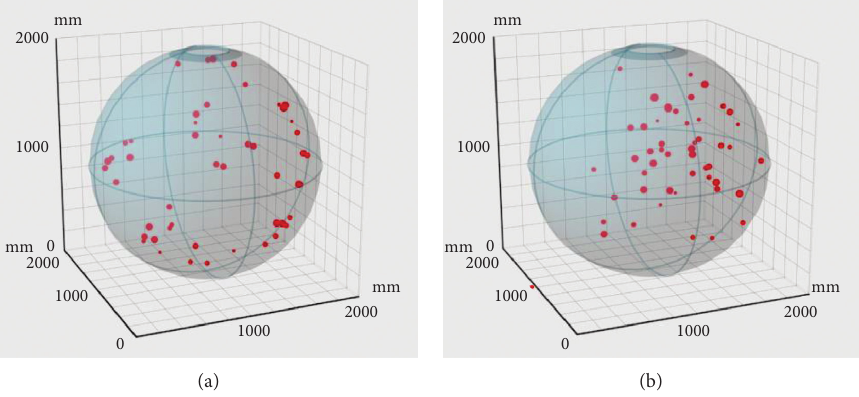
Figure 11: Results of multiobjective genetic algorithm for manned submersible cabin layout. (a) Optimization of equipment with low overlapping weight in the cabin. (b) Optimization of equipment with high overlapping weight in the cabin.